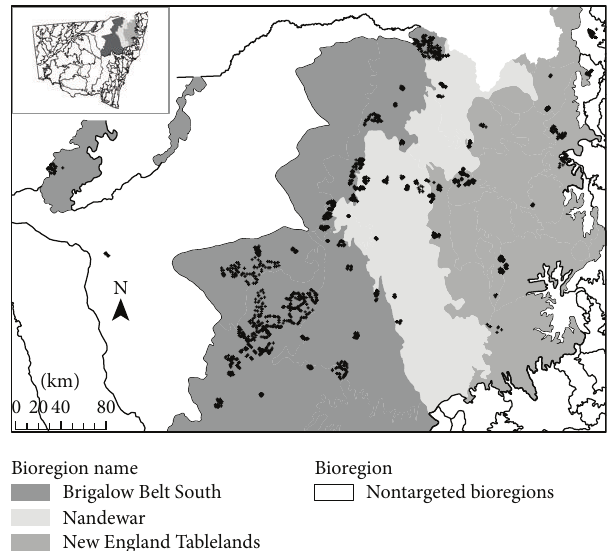
Figure 1: Location of the 2,341 allometric survey sites within northeastern New South Wales,